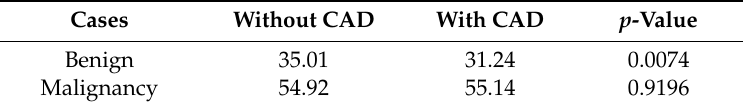
Table 6. The mean malignant potential score from the 19